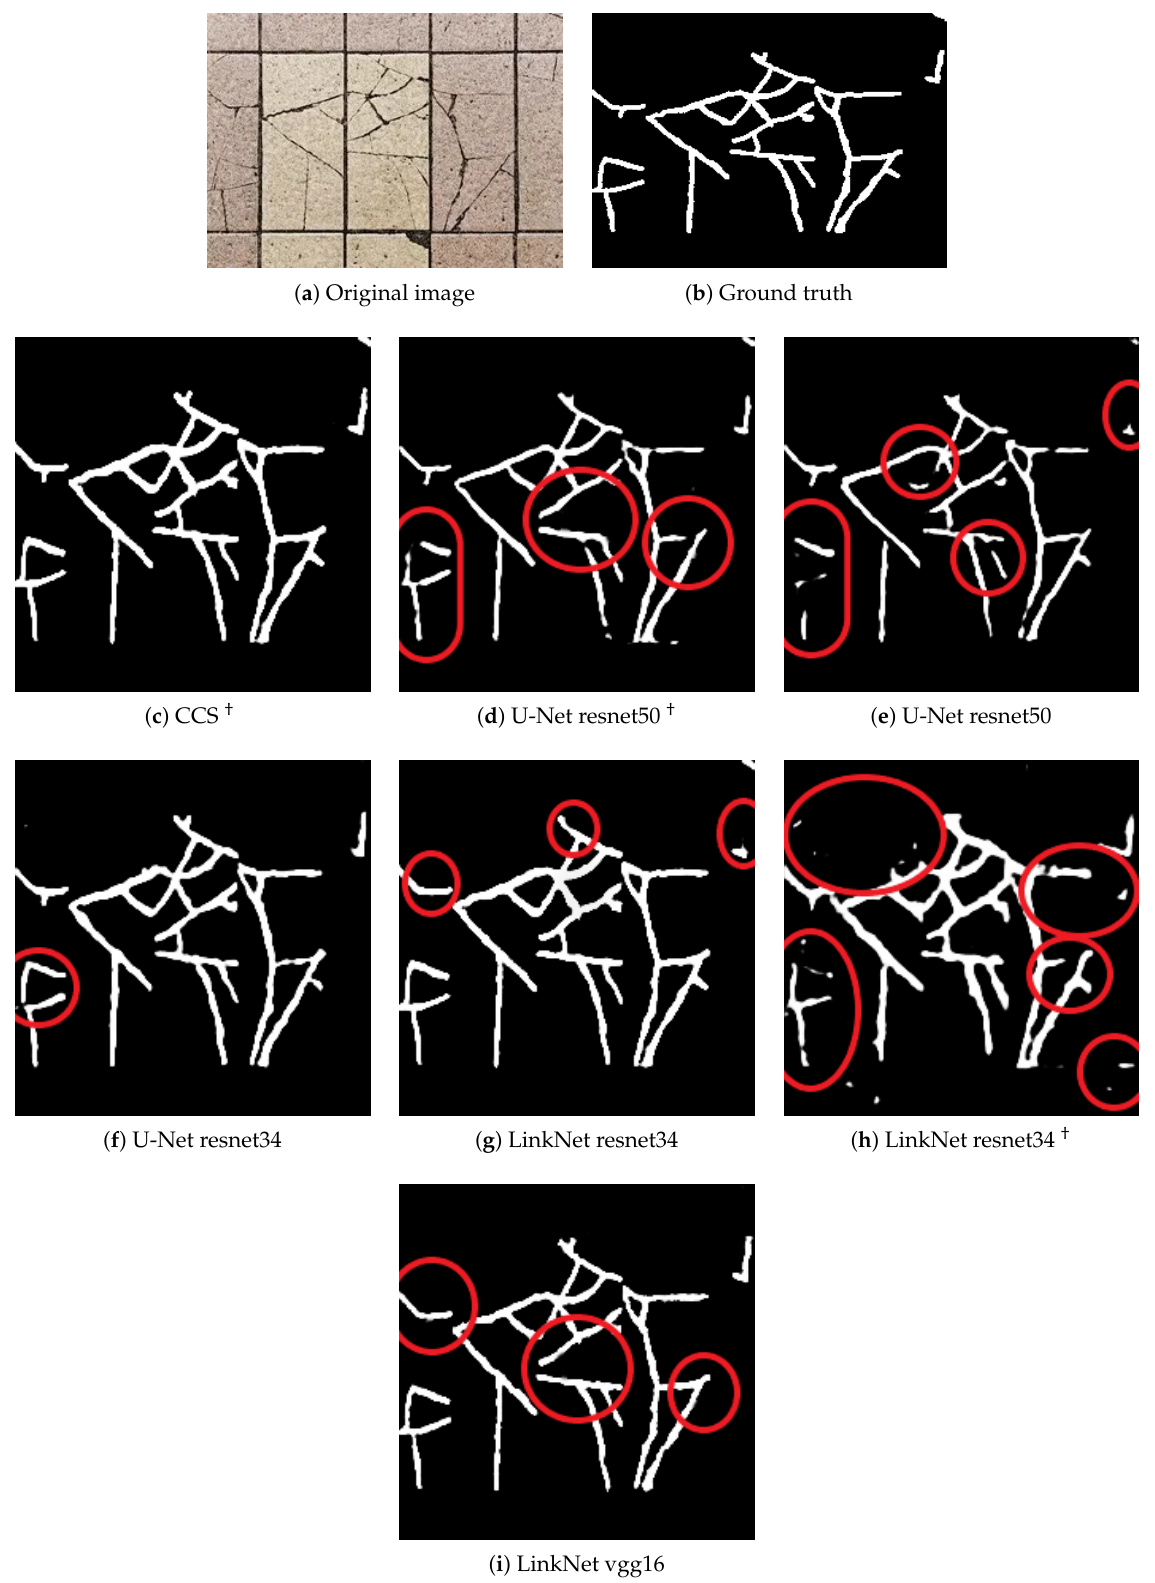
Figure 7. Example of ( a ) an original image and ( b ) the ground truth used for testing. Prediction of the ( c – f ) U-Net, where ( c ) is CCS, and ( g , h ) LinkNet models. The weights of a pre-trained network with ImageNet are used to initialize each of the models (For the models † , and weights were randomly